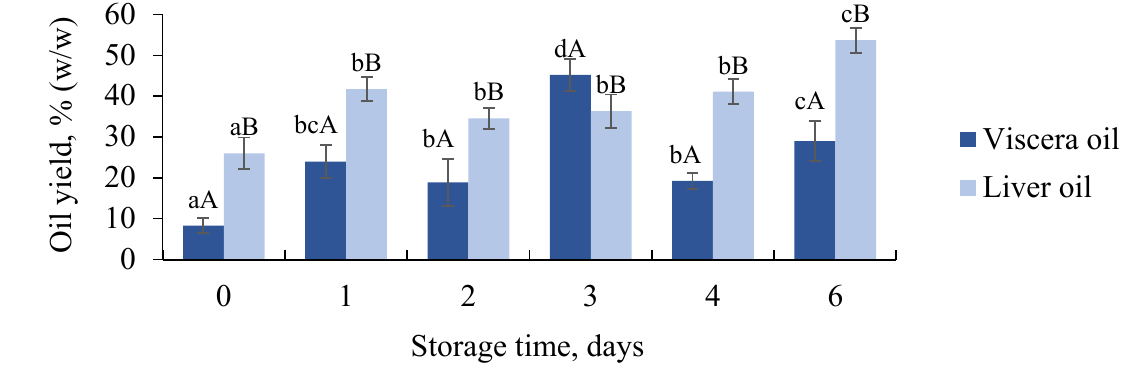
Figure 1. Oil yield (% w / w ) obtained after thermal processing of viscera and liver at different storage times. Significant difference ( p < 0.05) is shown as different letters between days for the same raw material ( a–c ) and between raw materials for the same day ( A–B ).